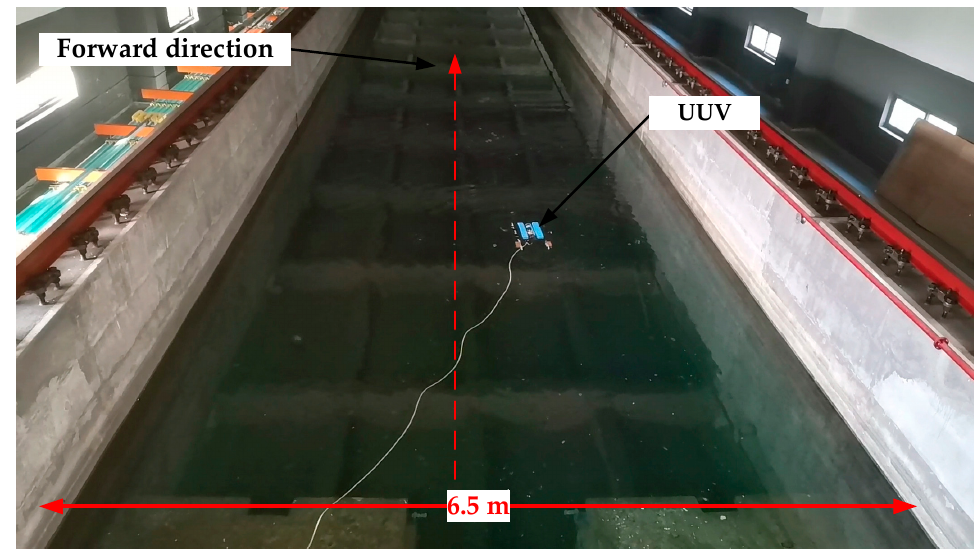
Figure 13. Test environment for autonomous heading planning experiment.